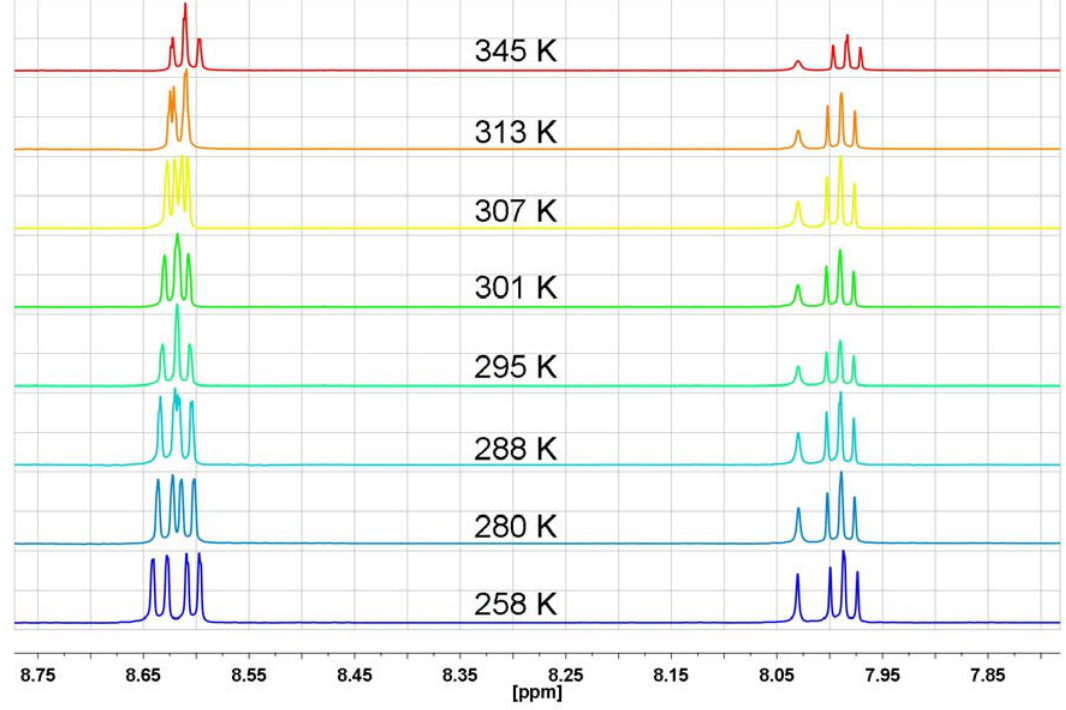
Figure 12. The aromatic proton range of the 1 H-NMR spectrum in DMF-d 1,8-naphthalenedicarboxylic anhydride at different temperatures.